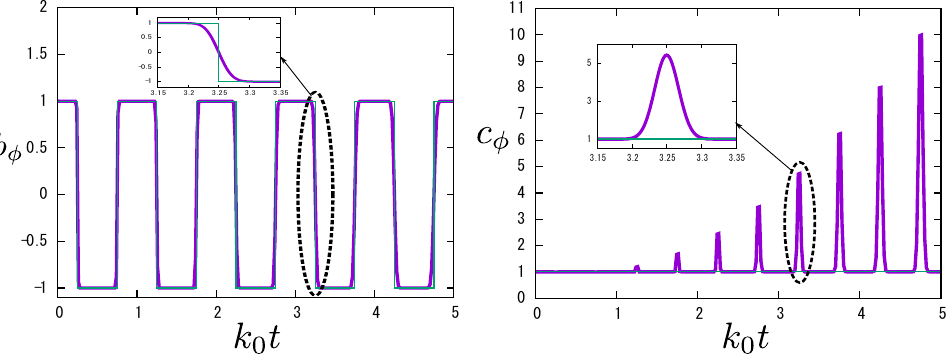
Figure 11 . Time dependence of b φ and c φ . Classical predictions for b φ and c φ are shown by green